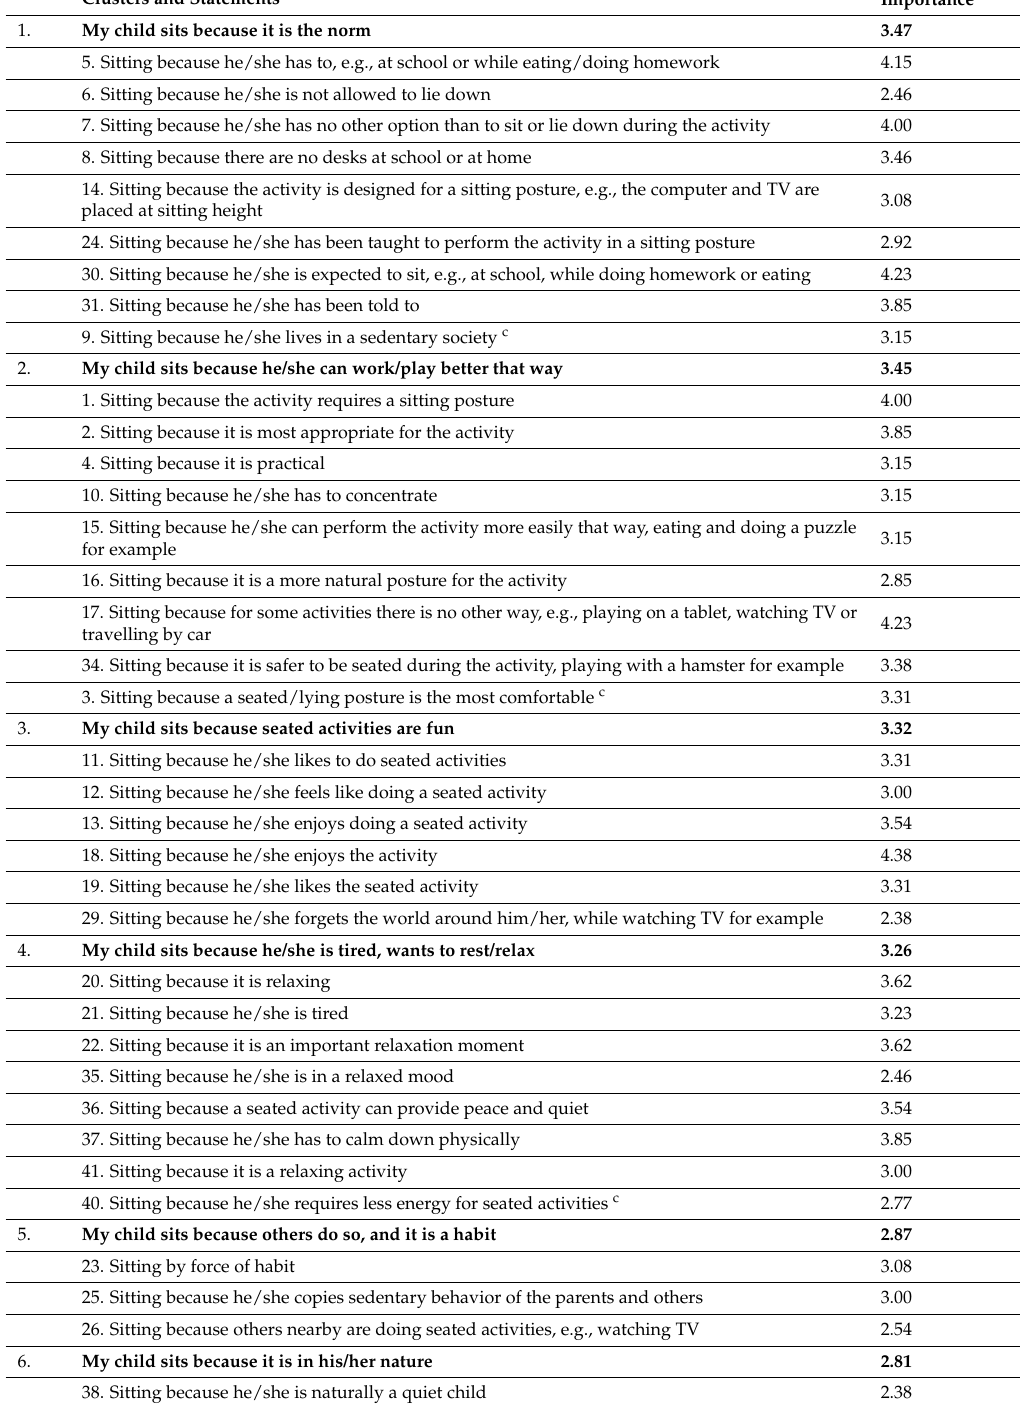
Table A12. Clusters, statements and importance ratings of parents (convenience sample) a